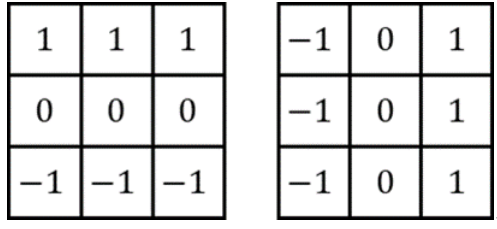
Figure 3. Prewitt convolution kernel.